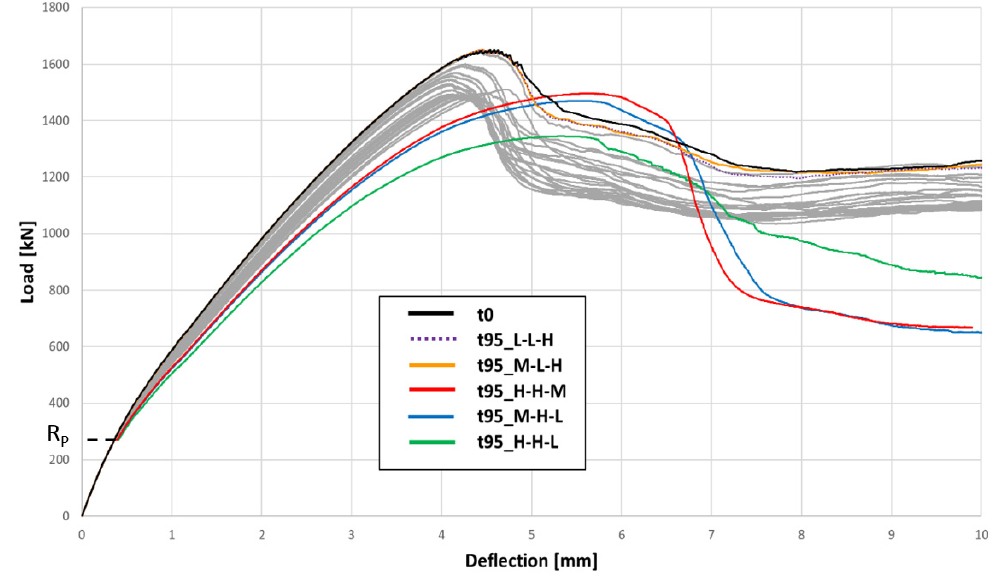
Figure 19. Envelope of load-deflection curves of chloride-induced corrosion analyses at 95 years.